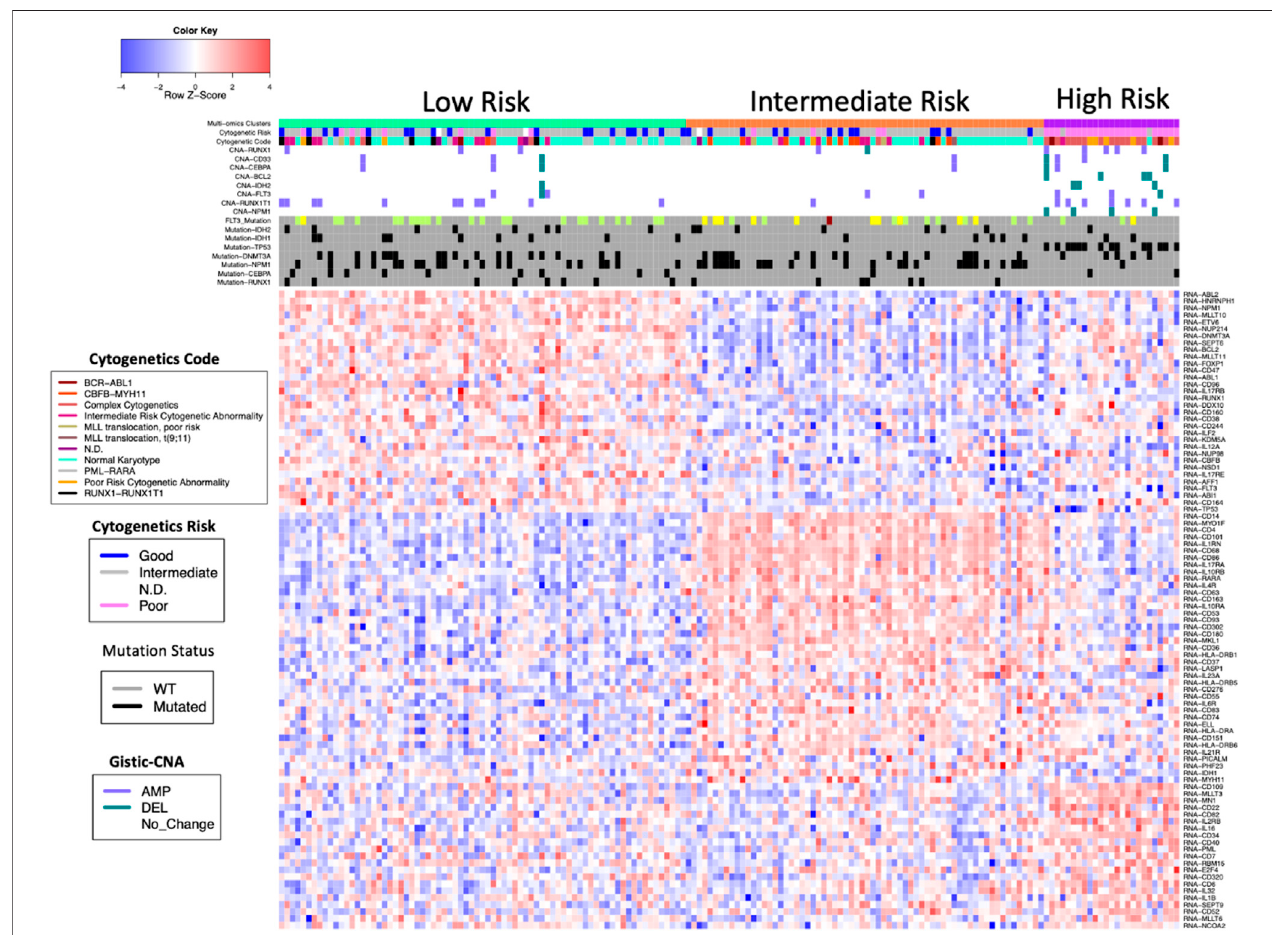
FIGURE 4 | Summary of molecular differences among the three patient subgroups.